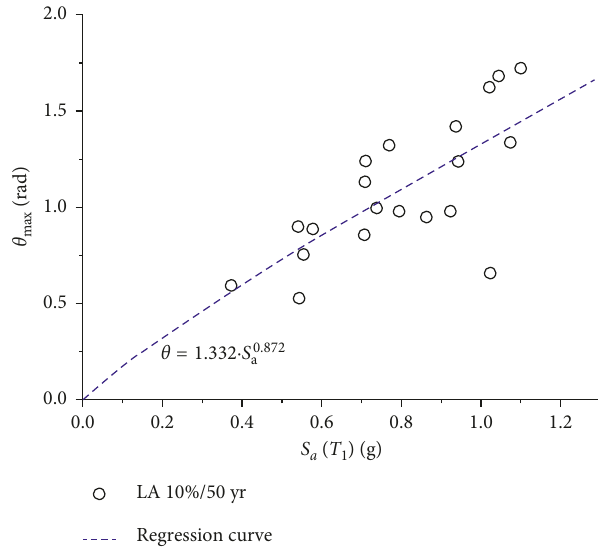
Figure 12: Diagram of fragility curves based on FEMA